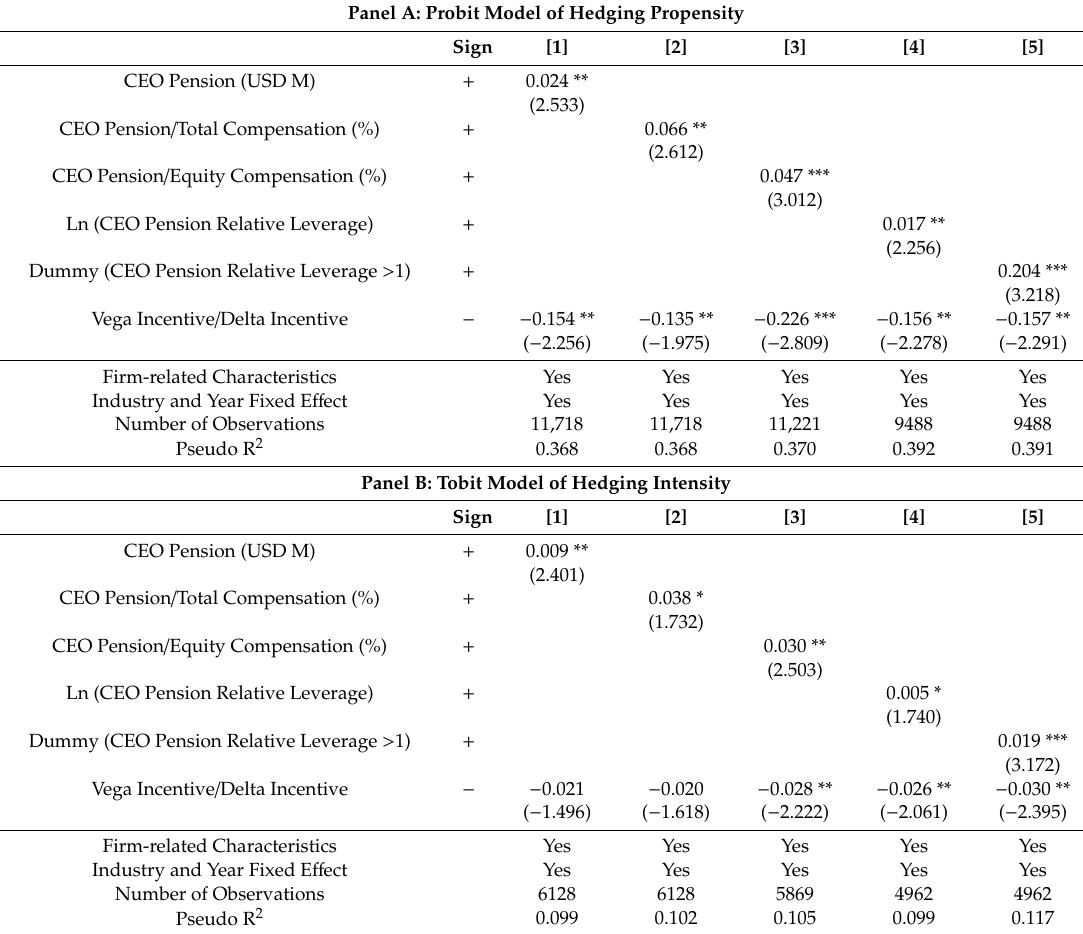
Table 4. Alternative Models of Impact of Pension Incentive on